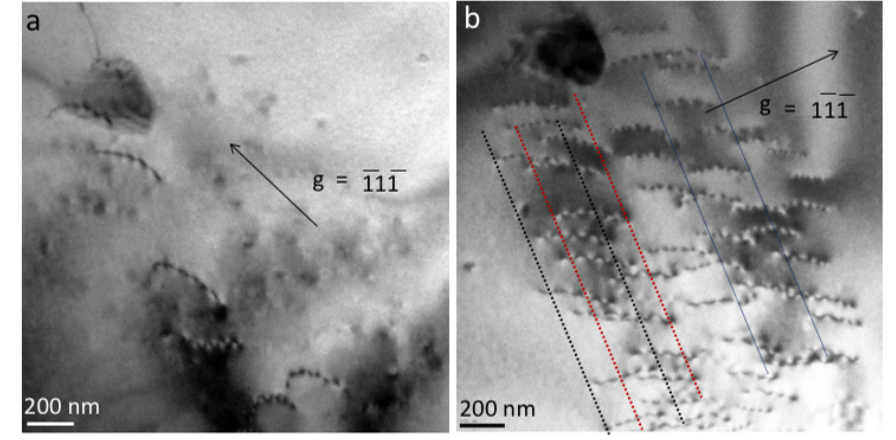
Figure 2. ( a ) A TEM image showing dislocations ahead of a sharp crack and a dislocation free zone